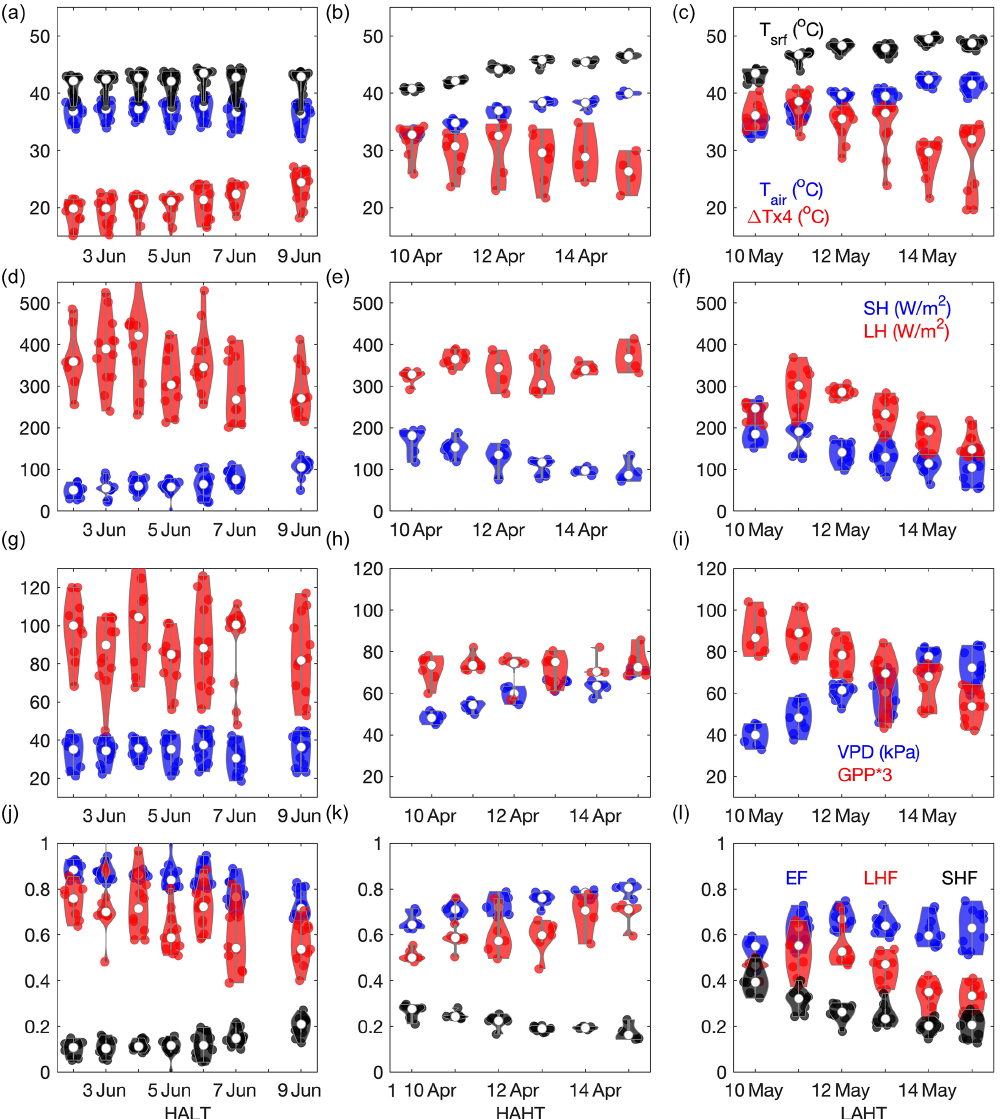
Figure 3. Distribution plots showing the variations in near-surface meteorology and surface fluxes during the cases. Panels (a) – (c) illustrate the time series of the midday (11:00–14:00LT) variation in T srf , T air and (–) (cid:49)T values during HALT, HAHT, and LAHT, respectively. Panels (d) – (f) are same as panels (a) – (c) but for SH and LH. Panels (g) – (i) are same but for VPD and GPP, and panels (j) – (l) are same but for EF, the latent heat fraction (LHF; red), and the sensible heat fraction